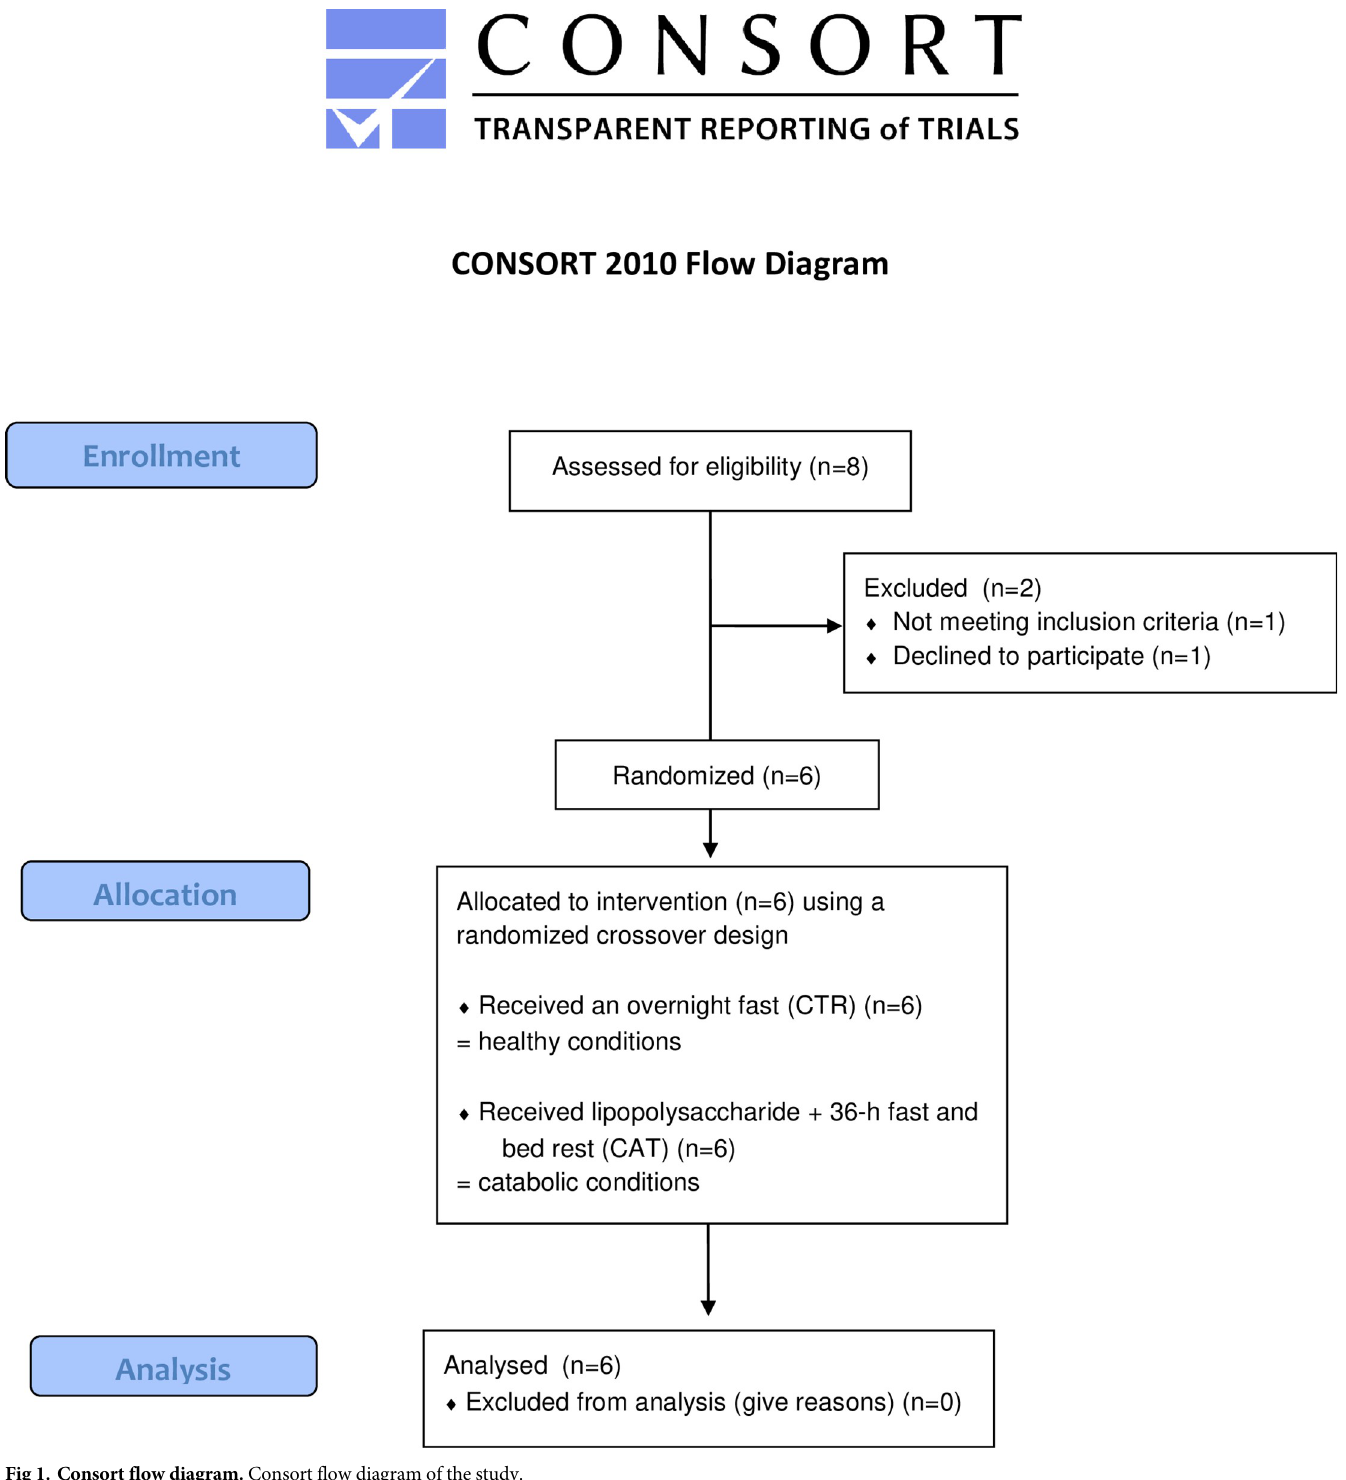
Fig 1. Consort flow diagram. Consort flow diagram of the study.